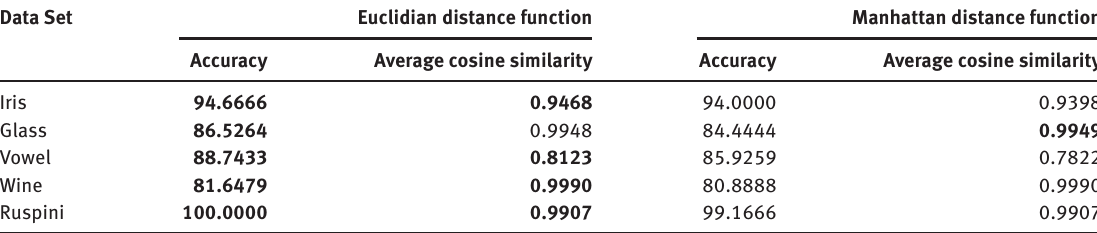
Table 4: Effect of Distance Functions on SSO.